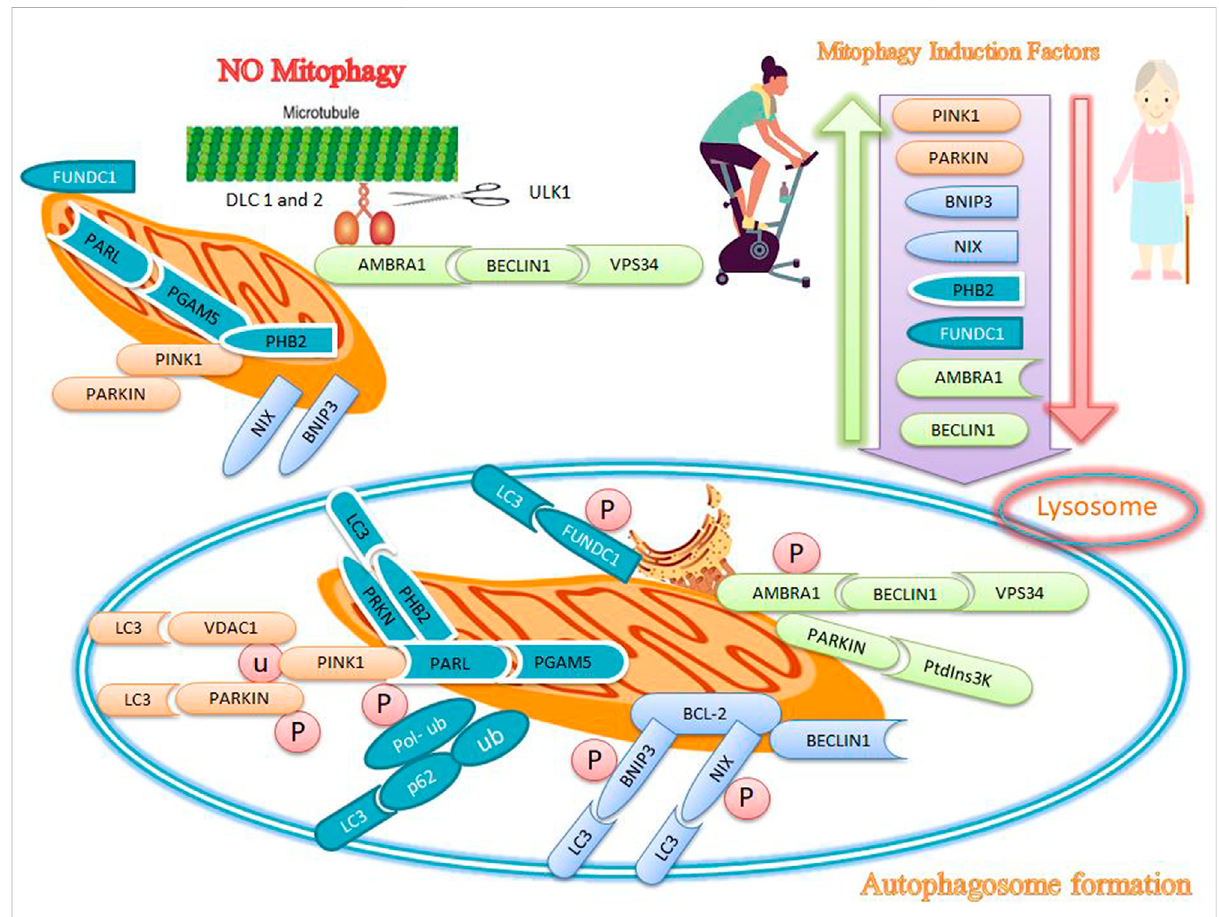
FIGURE 2 Effects of exercise and sarcopenia on mitophagy markers. Sarcopenia decreases mitophagy markers, while exercise appears to increase mitophagy markers such as PINK1, PARKIN, BNIP3, NIX, PHB2, FUNDC1, AMBRA1, and